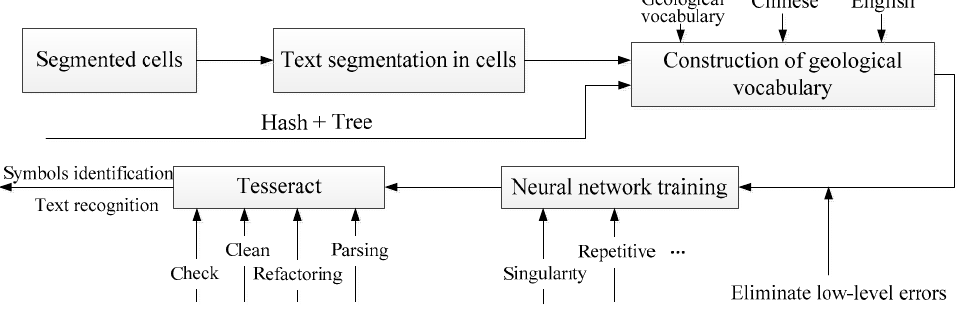
Figure 9. The specific implementation process and key technologies based on deep learning and Tesseract for content recognition.